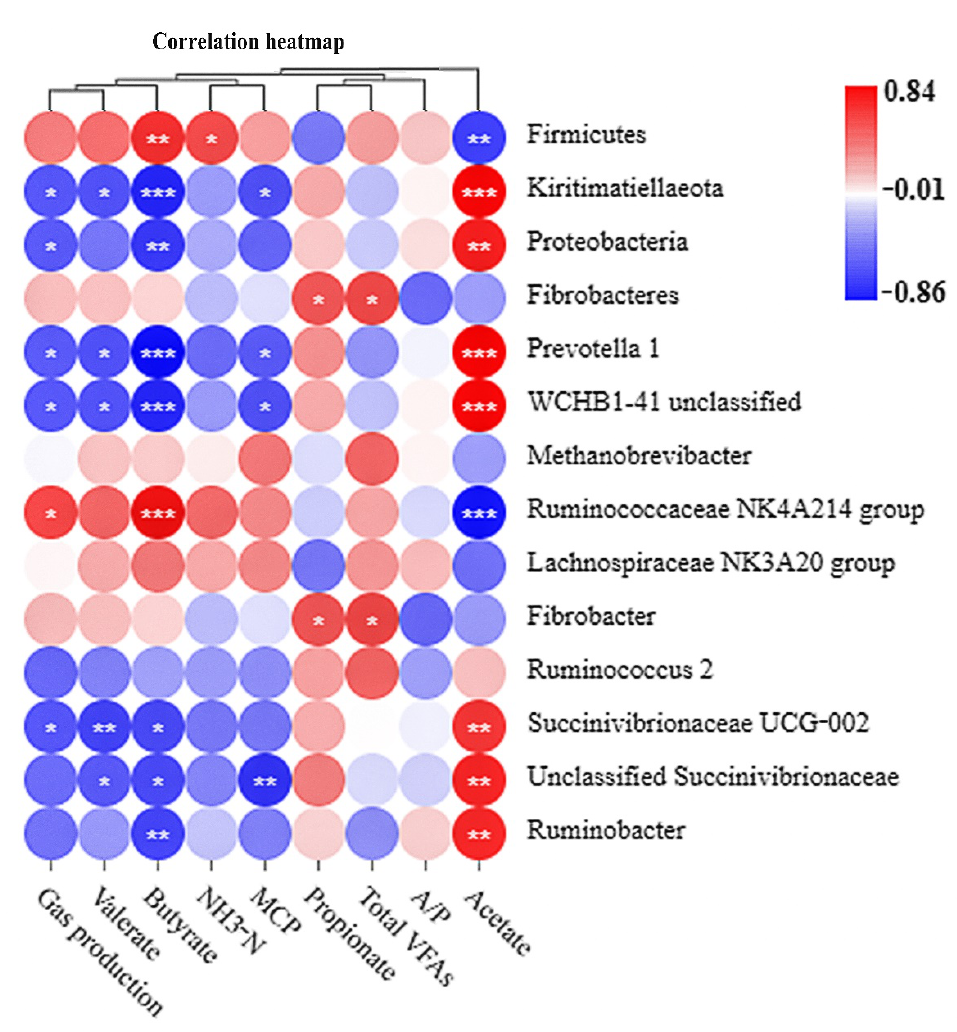
Figure 4. The correlation of gas production and rumen fermentation parameters with bacterial abundances in in vitro fermentation. The colors indicate positive (red, closer to 0.84) or negative (blue, closer to − 0.86) correlations between gas production and rumen fermentation parameters with bacterial abundances. NH 3 -N, amine nitrogen; MCP, microbial protein; A/P, ration of acetate to propionate; VFAs, volatile fatty acids. *, p < 0.05; **, p < 0.01; ***, p < 0.001.